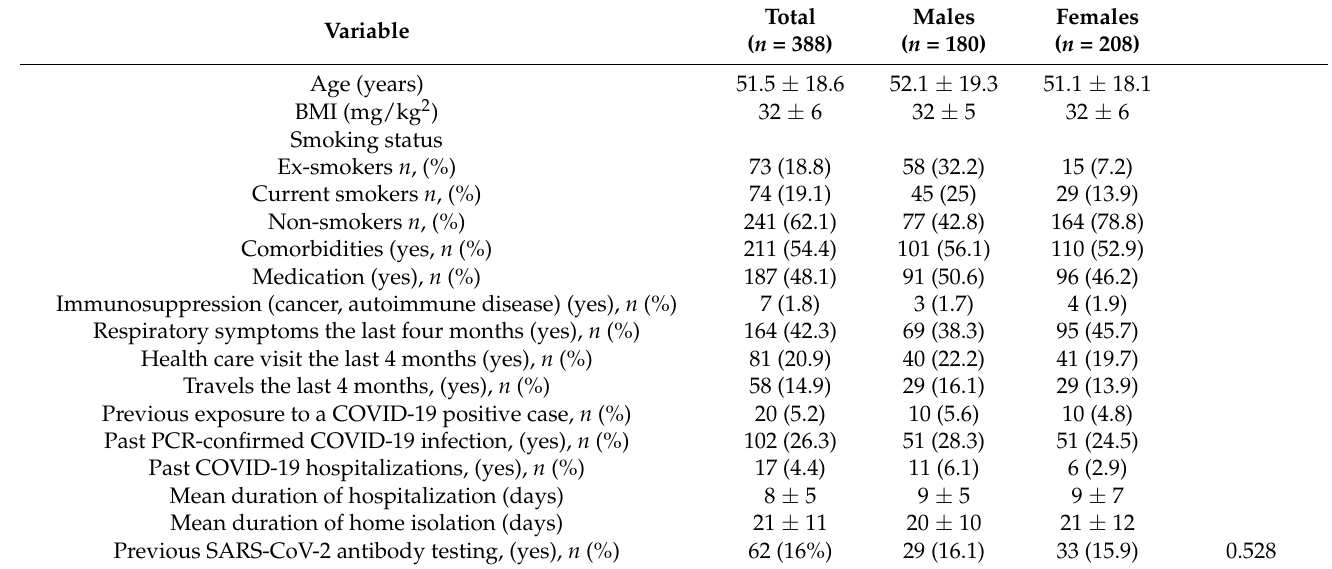
Table 1. Characteristics of the study population stratified by gender, n =